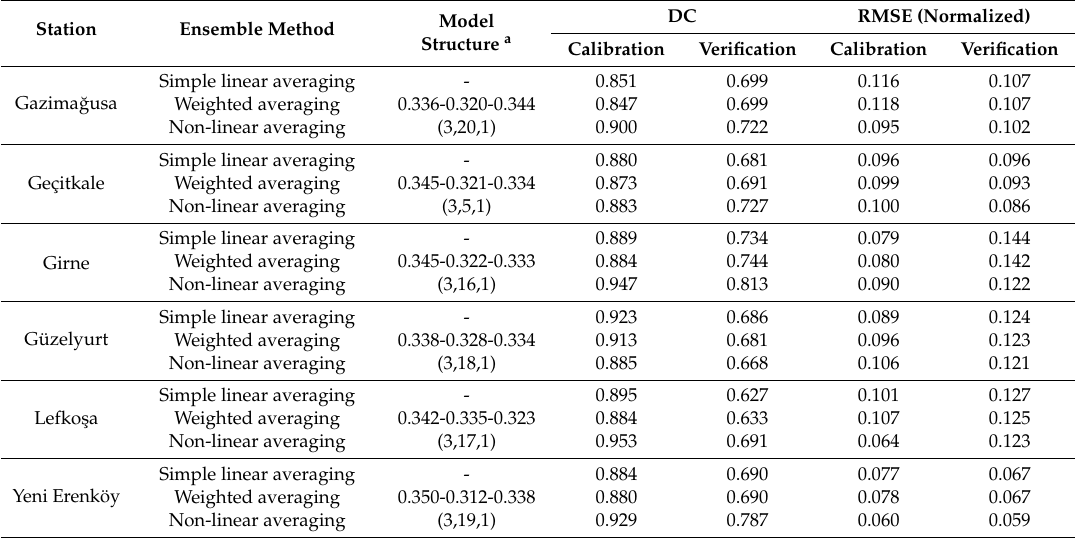
Table 8. Results of ensembles using linear, weighted and non-linear averaging methods for scenario 2.